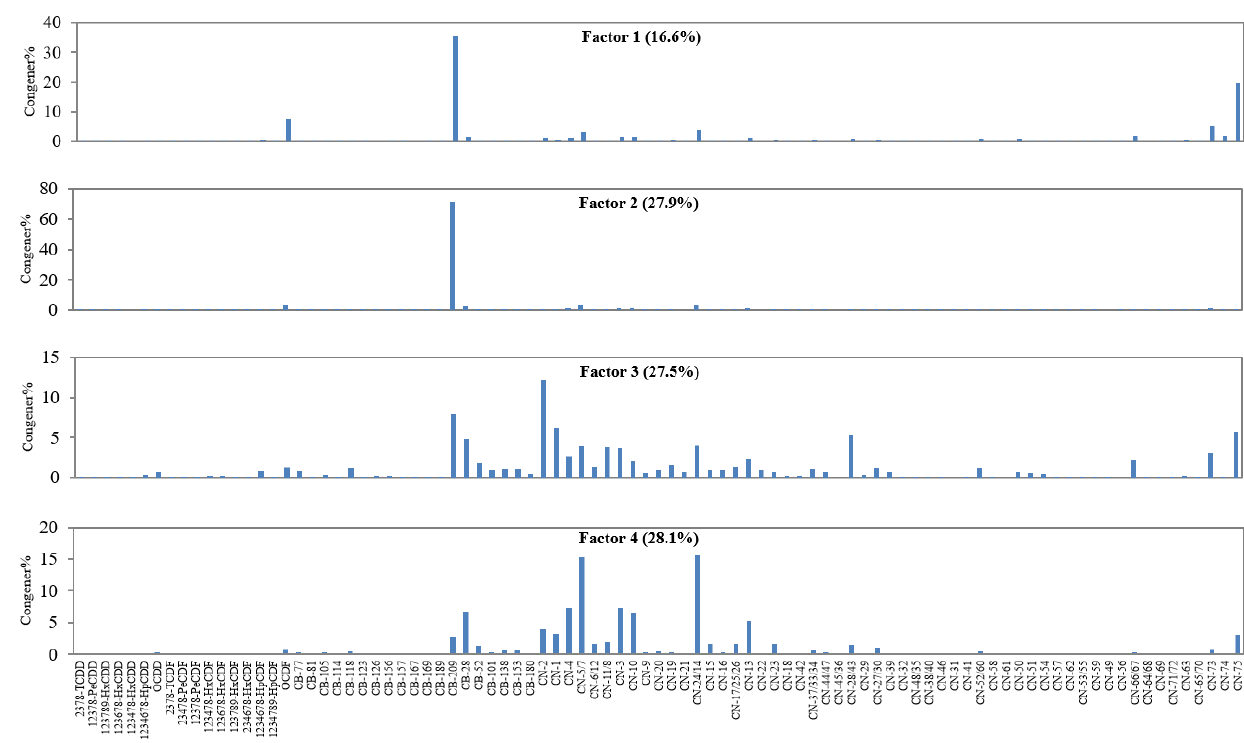
Figure 5. Congener profiles of four resolved sources (Factors) generated by PMF modle. Factor 1 accounted for 16.6% of total POPs (PCBs + PCNs + PCDD/Fs) in the data set. In factor 1, OCDF (7.30%), CB-209 (35.4%), and CN-75 (19.5%) with the highest degree of